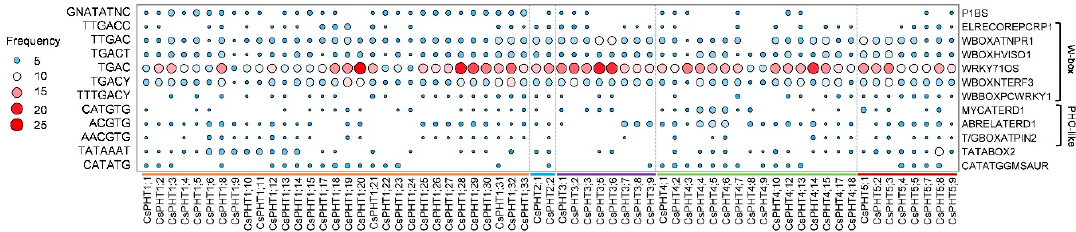
Figure 4. Frequency of Pi-starvation-related cis -elements in the 2-kb promoter region of CsPHT genes. The cis -elements were identified using the New PLACE database [56] and the dotplot was generated using TBtools [48].